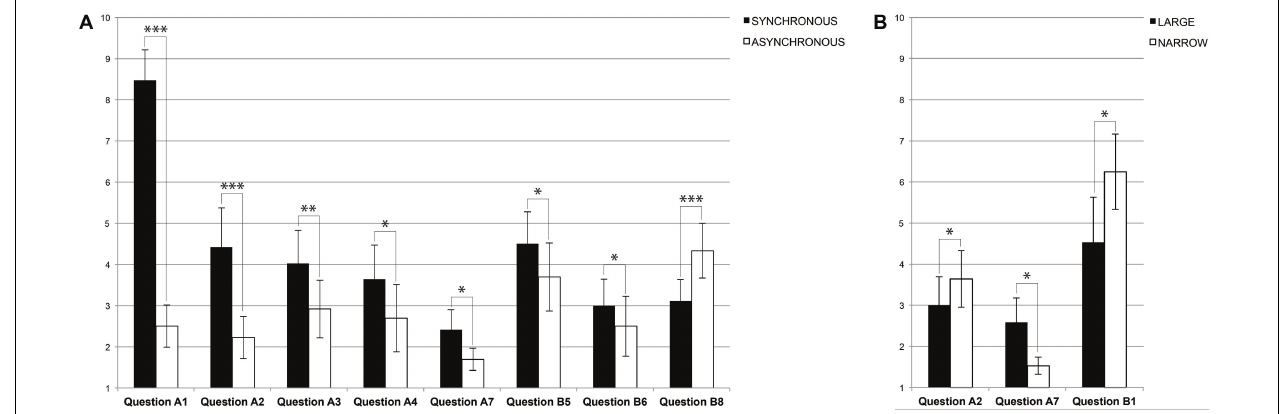
FIGURE 4 | Experiment 1 – Questionnaires. (A) Significant main stimulation effects in Experiment 1 from ANOVAs in the self-consciousness A and architecture B questionnaires ( ∗ p < 0.05; ∗∗ p < 0.01; ∗∗∗ p < 0.005). The plots are based on the average response calculated with non-normalized data; error bars represent standard errors. (B) Significant main interior effects in Experiment 1 from ANOVAs in the self-consciousness and architecture questionnaires ( ∗ p < 0.05). The plots are based on the average response calculated with non-normalized data; error bars represent standard